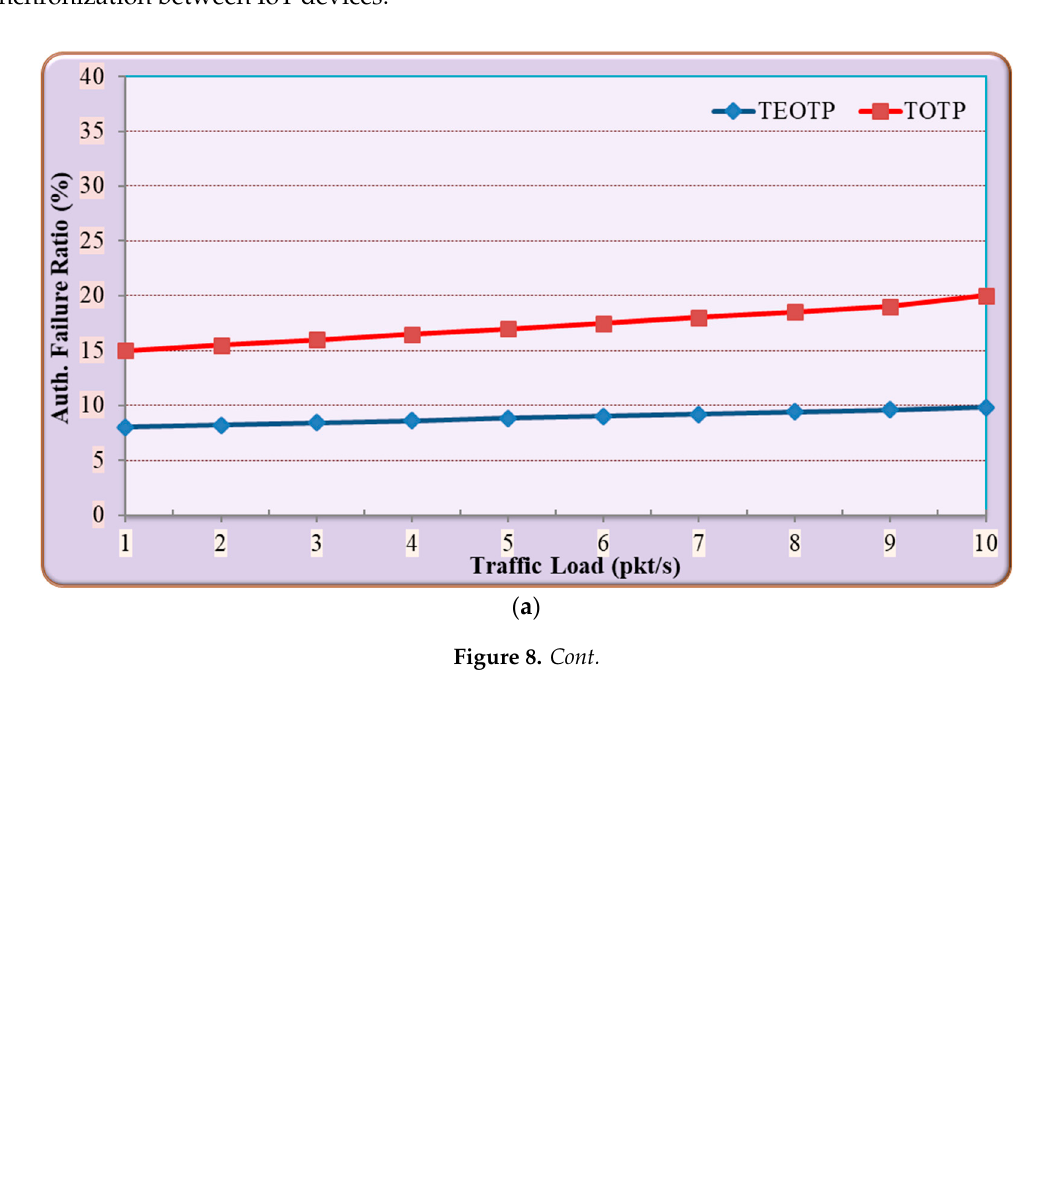
Figure 7. Impact of CMA authentication algorithms on IoT Performance ( a ) throughput; ( b ) latency; ( c ) packet loss